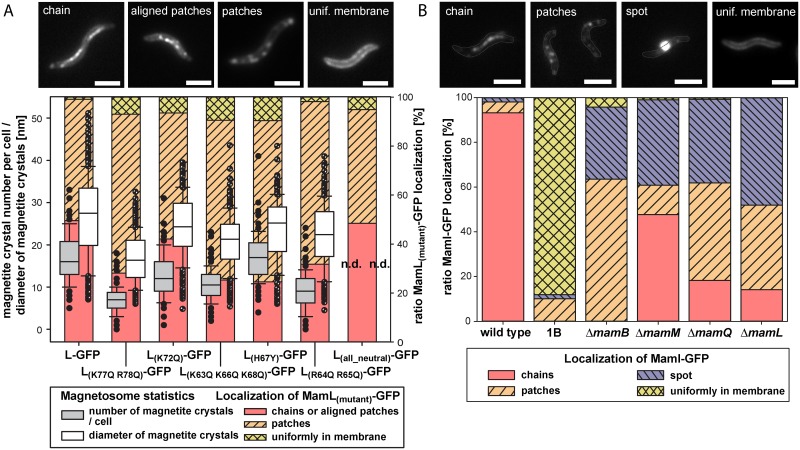
Localization of MamI-GFP in several mutants and complementation/localization assay of mutated MamL-GFP.(A) Effects of exchange of basic amino acid residues in the C-terminus of MamL, fused to EGFP by an alpha-helical linker. Quantitative analysis of magnetite crystal number/cell (grey) and magnetite crystal sizes (white) of MSR ΔmamL complemented with transposon-integrated PmamDC45-mamL-egfp, PmamDC45-mamLK77Q-R78Q-egfp, PmamDC45-mamLK72Q-egfp, PmamDC45-mamLK63Q-K66Q-K68Q-egfp, PmamDC45-mamLH67Y-egfp, PmamDC45-mamLR64Q-R65Q-egfp and PmamDC45-mamLall neutral-egfp. Box plots are indicating 10th and 90th percentiles (whiskers), 25th and 75th percentiles (box), median and outliers. Over 100 cells and 200 magnetosomes where analyzed for each strain. For quantitative analysis of MamL(mutant)-EGFP localization (colorful bars in background), fluorescence patterns were grouped into three classes (examples are indicated; chain and aligned patches are visualized as one class). Scale bars: 2 μm. (B) Quantitative analysis of localization of plasmid expressed PmamDC45-mamI-egfp in MSR-1, MSR 1B, ΔmamB, ΔmamM, ΔmamQ and ΔmamL. The localization patterns in individual cells were grouped into four different classes (examples are indicated; boundary of cells are outlined). More than 100 cells where analyzed for each strain. Scale bars: 2 μm.